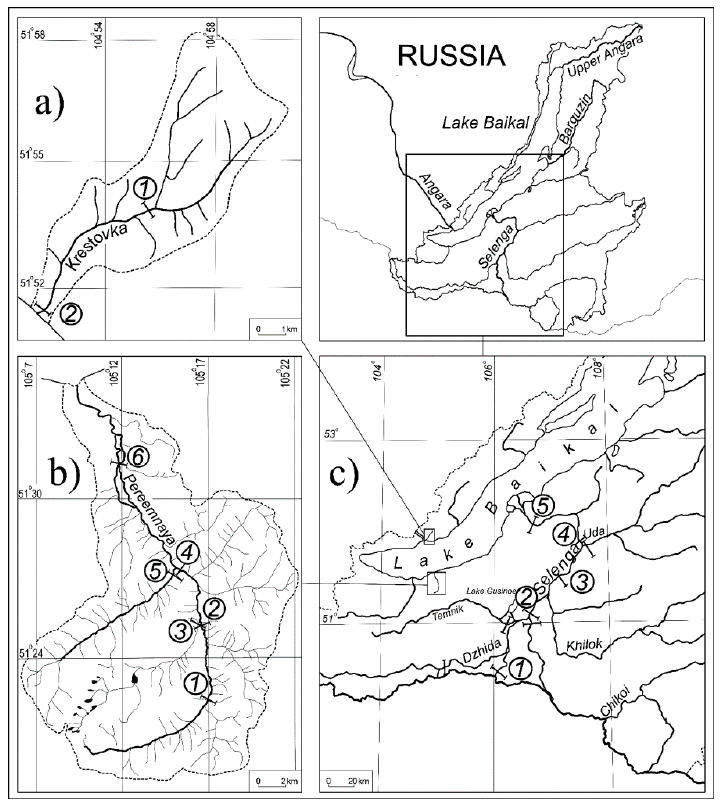
Figure 1. Study area. ( a ) Krestovka, ( b ) Pereemnaya, ( c ) Selenga.